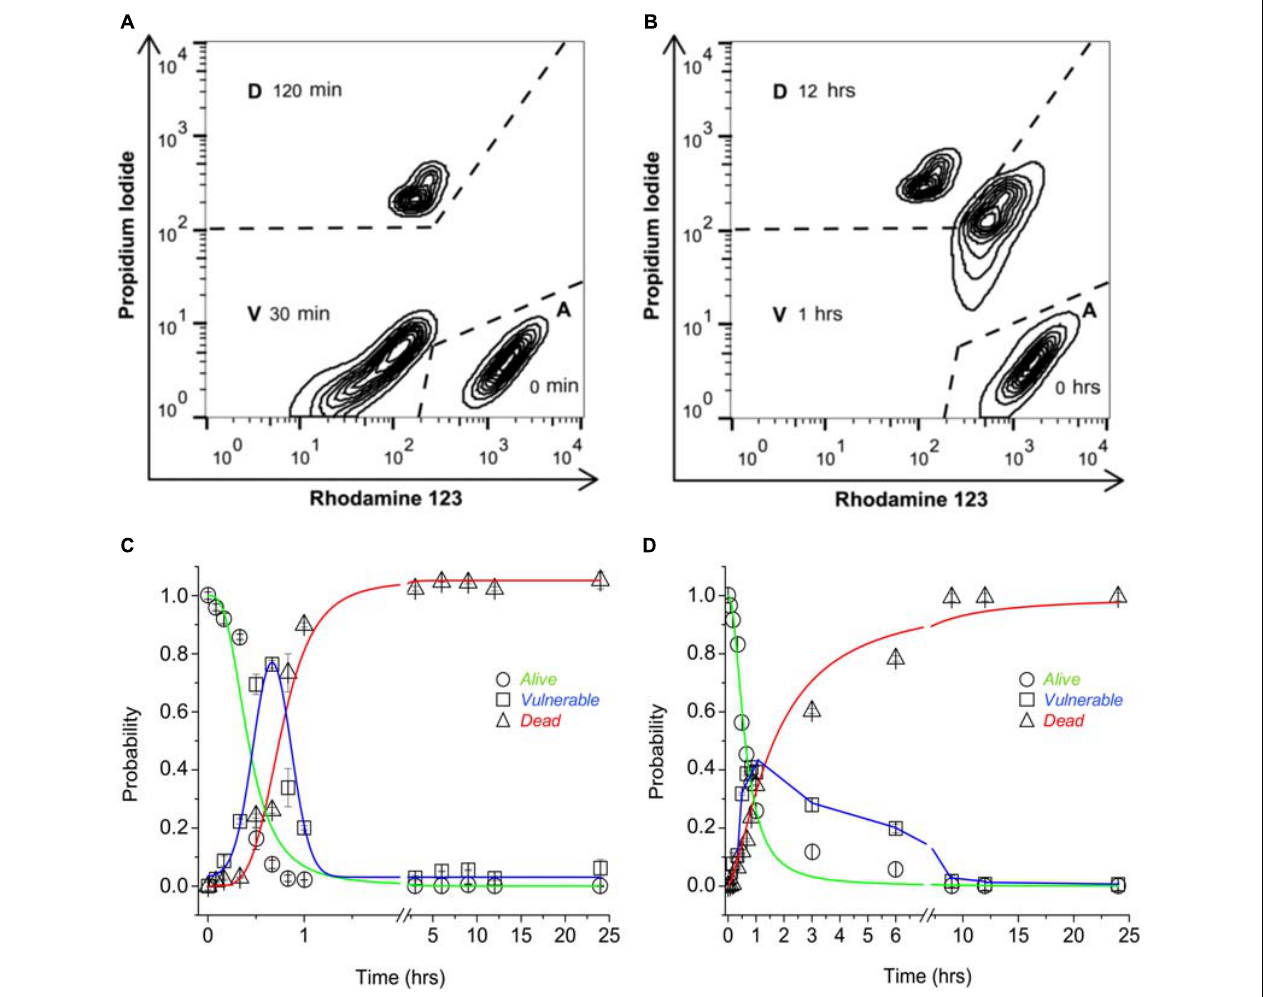
FIGURE 1 | Three-state model of cell death. Representative flow cytometry dot plot output depicting 24-h exposure of non-transfected wt-HeLa cell phenotype exposed to 10 µ M FCCP (A) and 10% ethanol (B) . Cell death progression was evaluated using PI (to assess plasma membrane integrity) and Rho123 (to assess mitochondrial membrane potential). Cell state progression is symbolized as A (alive), V (vulnerable), and D (dead). Replicate experiments [from (A,B) ] were performed for different times between 0 and 24 h, and were normalized against P A = 1 to determine the probability for cell state [ (C,D) respectively]. Data are shown as mean ± SEM ( n =